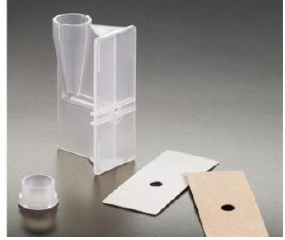
Figure 3. Example of cytofunnel.